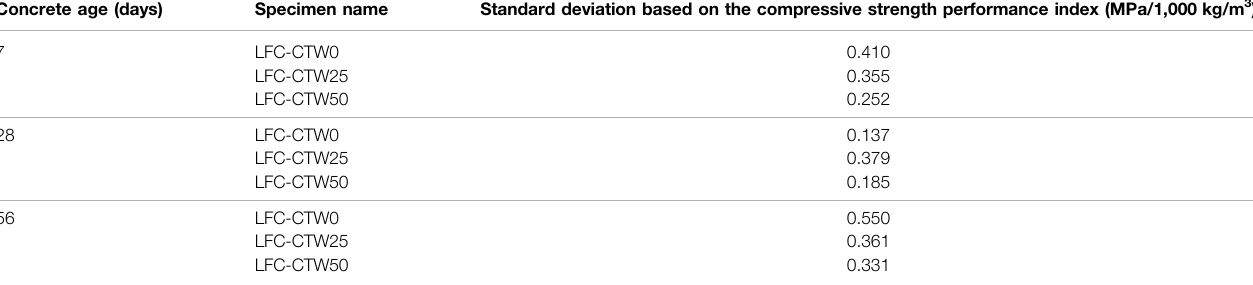
TABLE 5 | Standard deviation of the compressive strength performance index for each